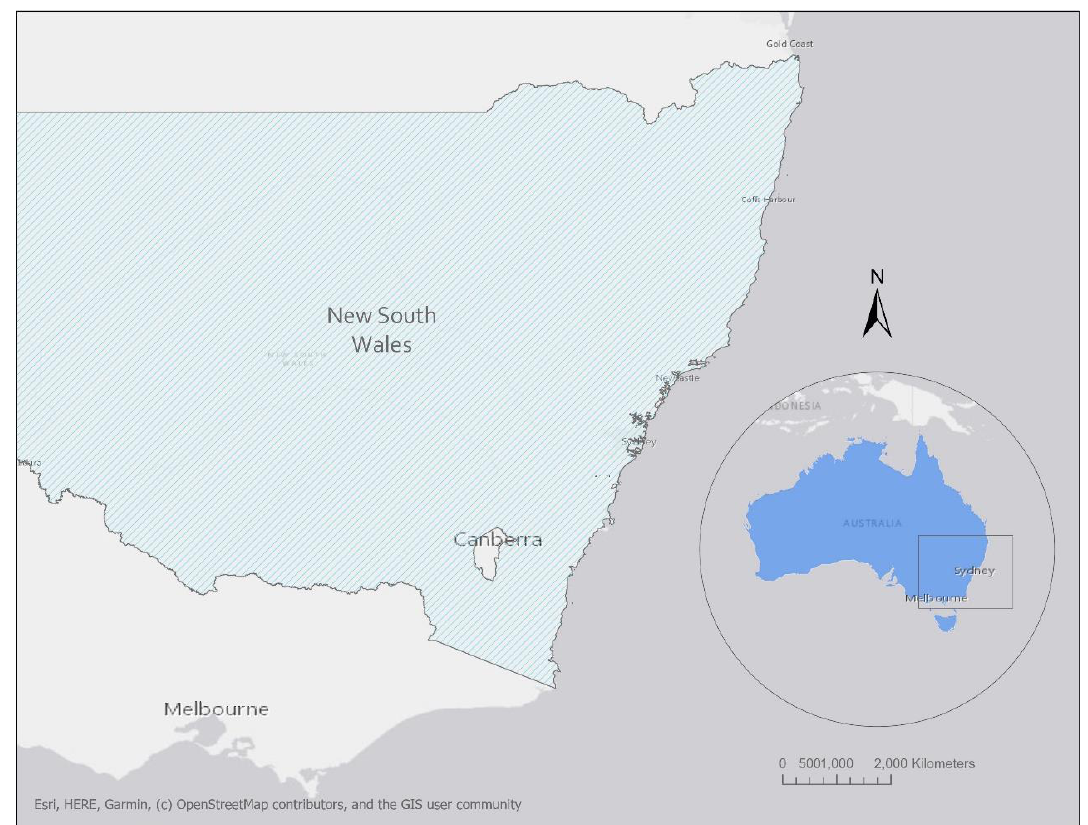
Figure 1. The NSW study area.